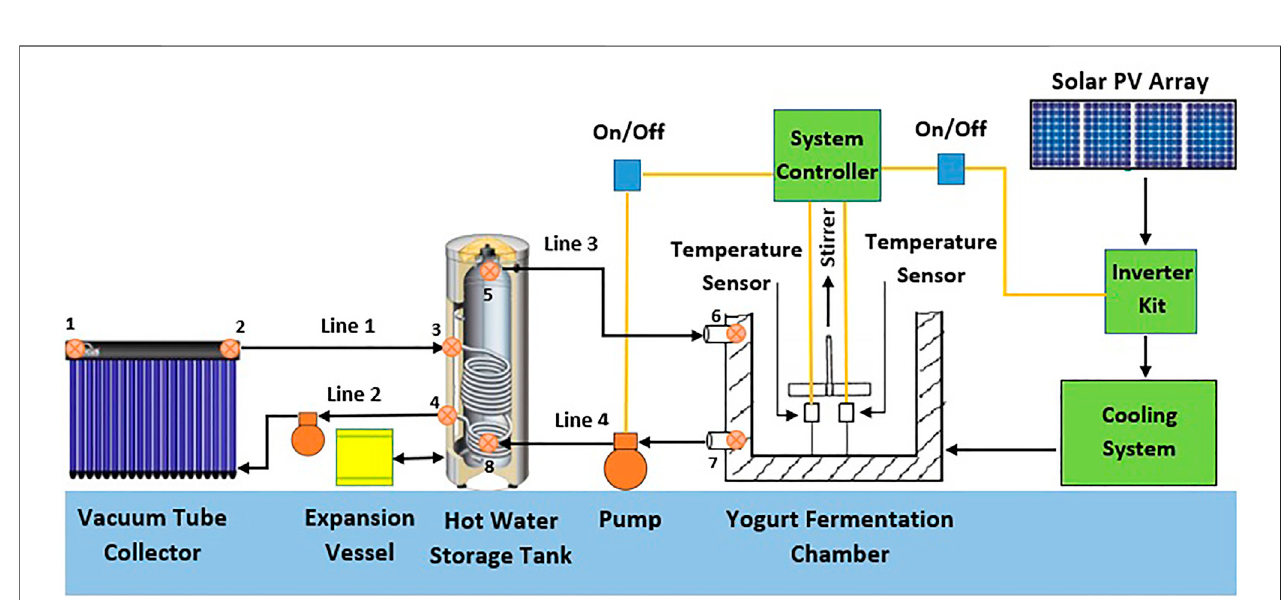
FIGURE 2 | Layout of the experimental setup of the solar assisted yogurt processing unit.